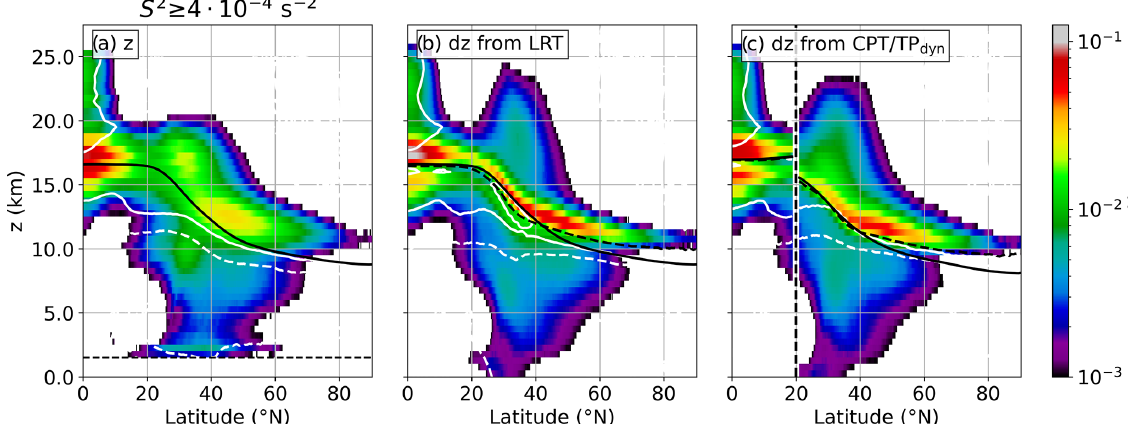
Figure 5. Northern hemispheric occurrence frequency distribution of grid volumes that exhibit strong vertical wind shear S 2 ≥ S 2 t , from 1 January 2008 to 31 December 2017. Logarithmic frequency contour, vertically binned with d z = 500 m. (a) Geometric altitude as the vertical coordinate. Solid bold black line indicates mean LRT altitude for all 10 years and the whole Northern Hemisphere. Dashed thin black line indicates the effect of the cut-off of 1.5km above orography. Solid (dotted) white line indicates where decreasing (increasing) horizontal winds with altitude constitute 75% of the strong vertical wind shear S 2 ≥ S 2 t . (b) As in panel (a) but with a LRT-relative vertical coordinate and with mean LRT altitude for profiles with S 2 ≥ S 2 t restored (dashed bold black line). Solid bold black line as in panel (a) . (c) As in panel (b) but from 0–20 ◦ N with the cold-point tropopause (CPT) as a reference altitude, and north of 20 ◦ N with the dynamic tropopause ( Q = 2pvu) as a reference altitude.